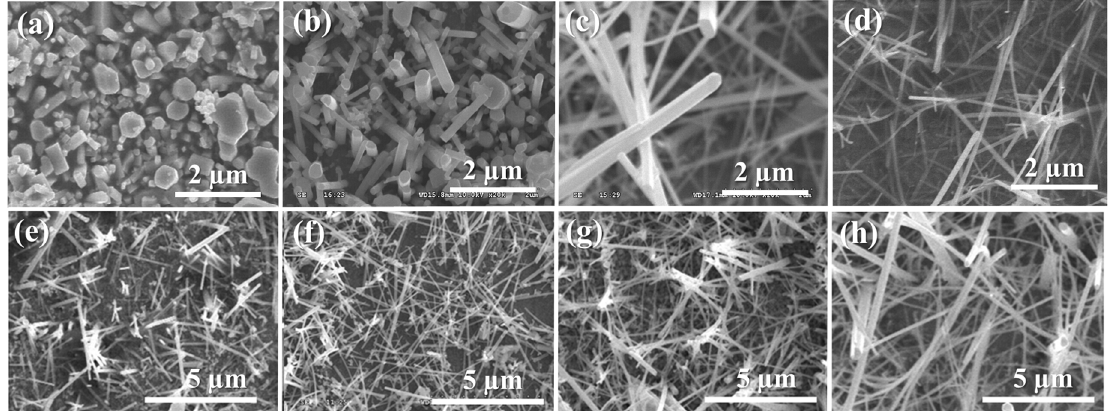
Figure 2. SEM images of as-prepared free-standing Cu 2 S nanowires grown under different reaction conditions. For the first four conditions, ( a ) 5, ( b ) 7.5, ( c ) 10, and ( d ) 20 g NaOH are added with 1 g cysteine and 7 mL ethylenediamine at 70 °C for 10 h. The other four conditions 10 g NaOH, 1 g cysteine, and 7 mL ethylenediamine at 70 °C are controlled for ( e ) 1, ( f ) 3, ( g ) 5, and ( h ) 10 h.